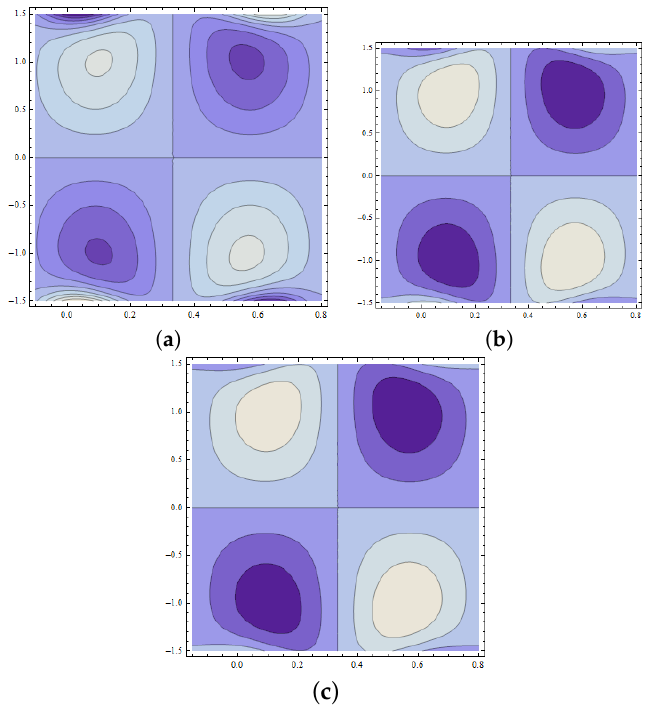
Figure 24. Pattern of streamlines when (cid:101) = 0.1, t = 0.1, m 1 = 2, E 1 = 0.2, E 2 = 0.2, E 3 = 0.3, n = 0.4, m = 0.04 and We = 0.4 with ( a ) n = 0.4, ( b ) n = 0.8, ( c ) n = 0.9